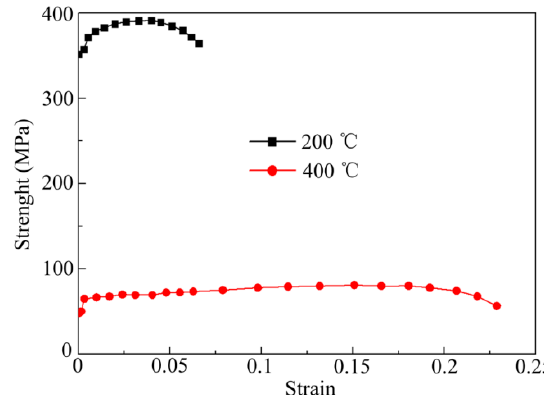
Figure 9. Stress–strain of materials at different temperatures.